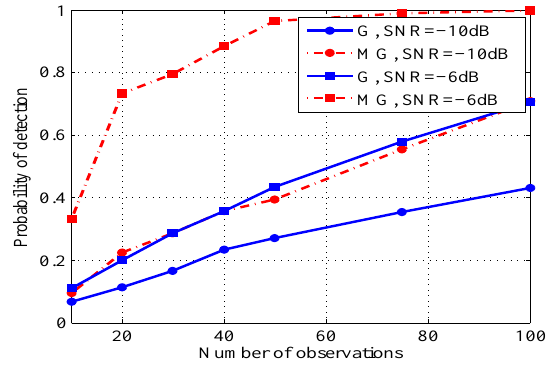
Figure 10. Probability of detection: DED and OSD vs. M for different primary SNRs | Rayleigh fading | Gaussian and mixture Gaussian noises | Gaussian primary signal.